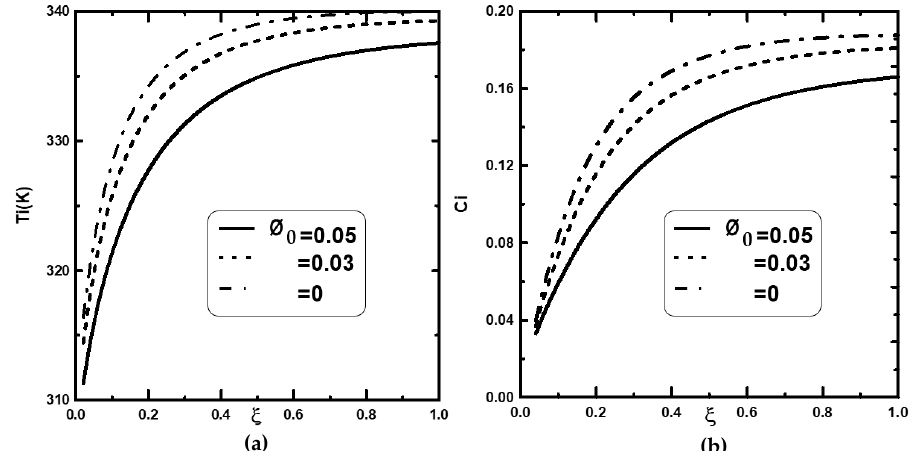
Figure 3. Effect of inlet nanoparticles volume fraction on the temperature ( a ) and the vapor concentration ( b ) at the interface liquid-gas: T 0 = 293.15 K, T 0L = 293.15 K, q 1 = − 1000 W/m 2 , T w = 293.15 K, c 0 = 0.3, u 0 = 1 m/s, m 0L = 0.015 kg/m.s, H = 1 m, d = 0.015 m, p 0 = 1 atm.